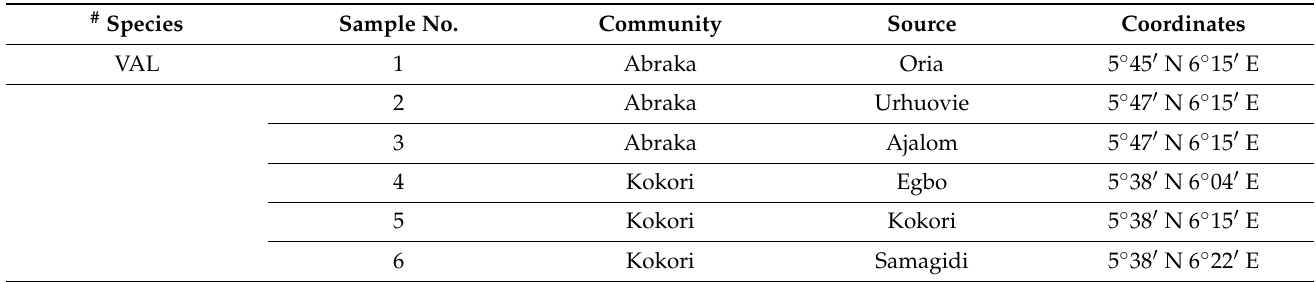
Table 1. List of tested samples from Kokori and Abraka, Delta State, Nigeria. Legend: VAL, Vernonia amygdalina leaf; OGL, Ocimum gratissimum